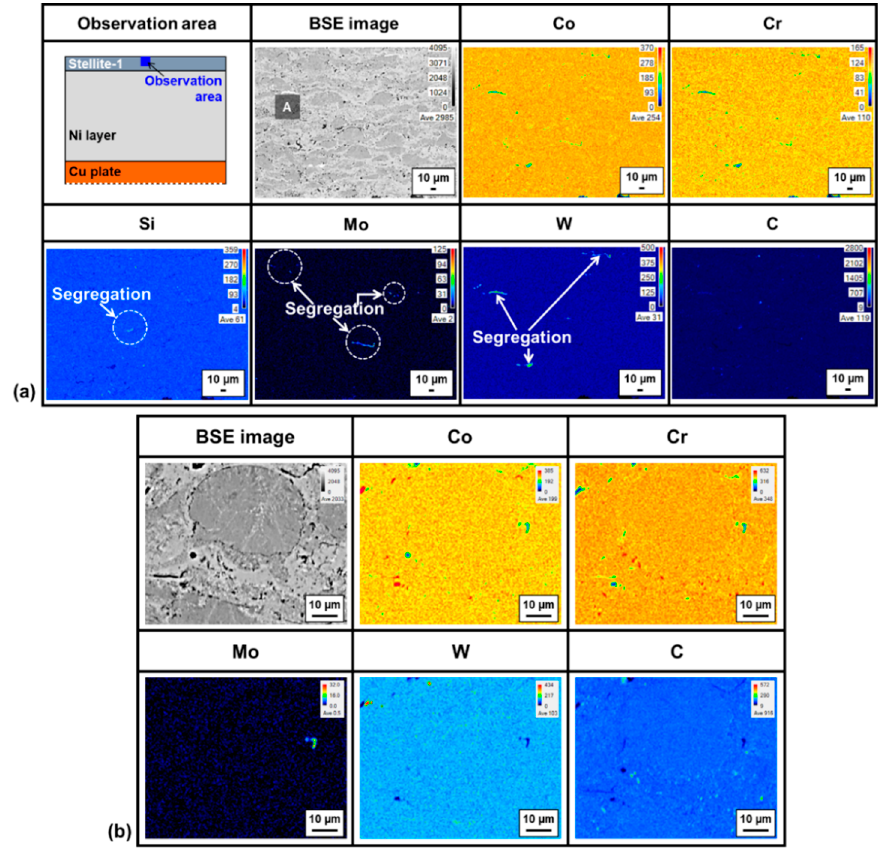
Figure 4. Cross-sectional OM and SEM (backscattered electron mode) micrographs of the as-sprayed Stellite-1 coating.